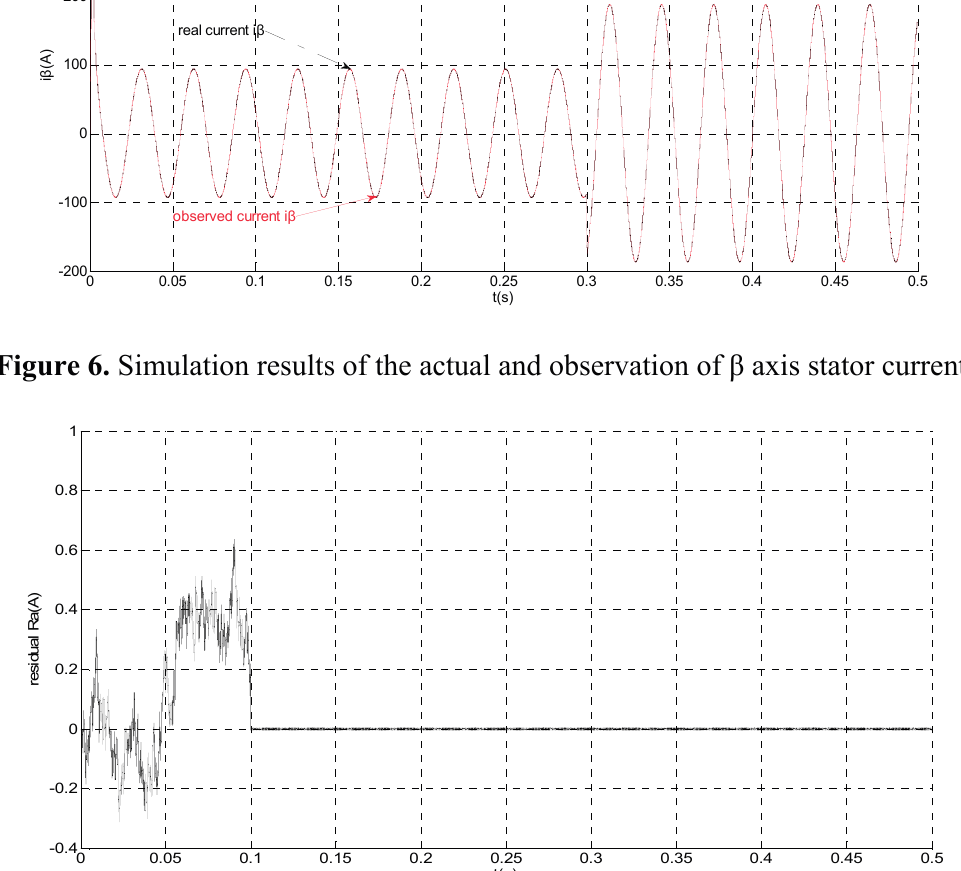
Figure 7. Simulation result of current residual in phase